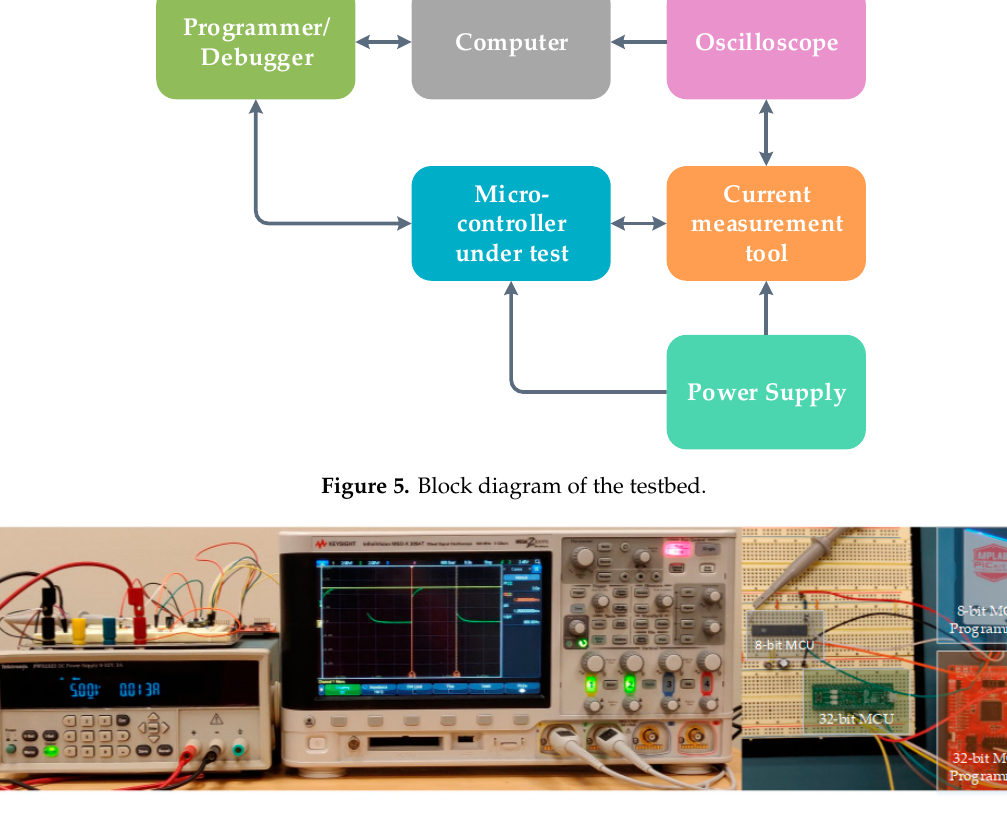
Figure 6. Experimental setup for measuring execution time.